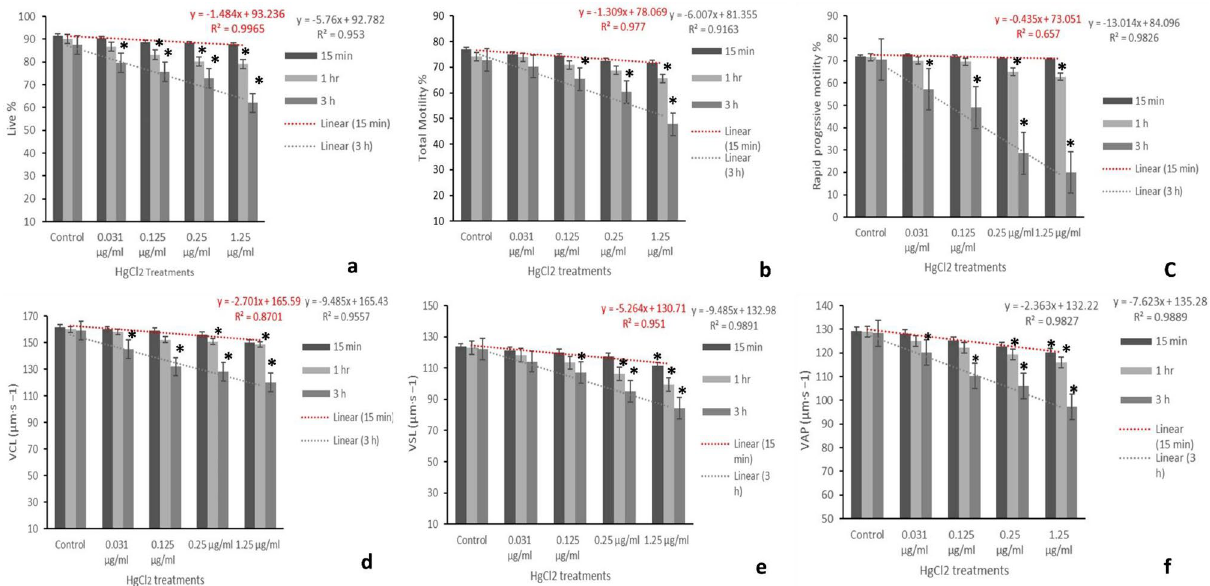
Figure 1. The relationship between different concentrations of HgCl 2 and computer-assisted semen analysis (CASA) kinematic parameters for per cent live ( a ), per cent total motility ( b ), per cent rapid progressive ( C ), VCL ( d ), VSL ( e ), VAP ( f ). Linear regression lines are shown along with the coefficients of determination ( R 2 ) for 15 min and 3 h. Each data point represents the mean ± SE value of repeated measurements from six male